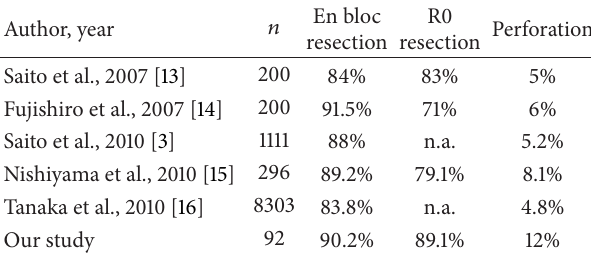
Table 4: Previous reports of colorectal